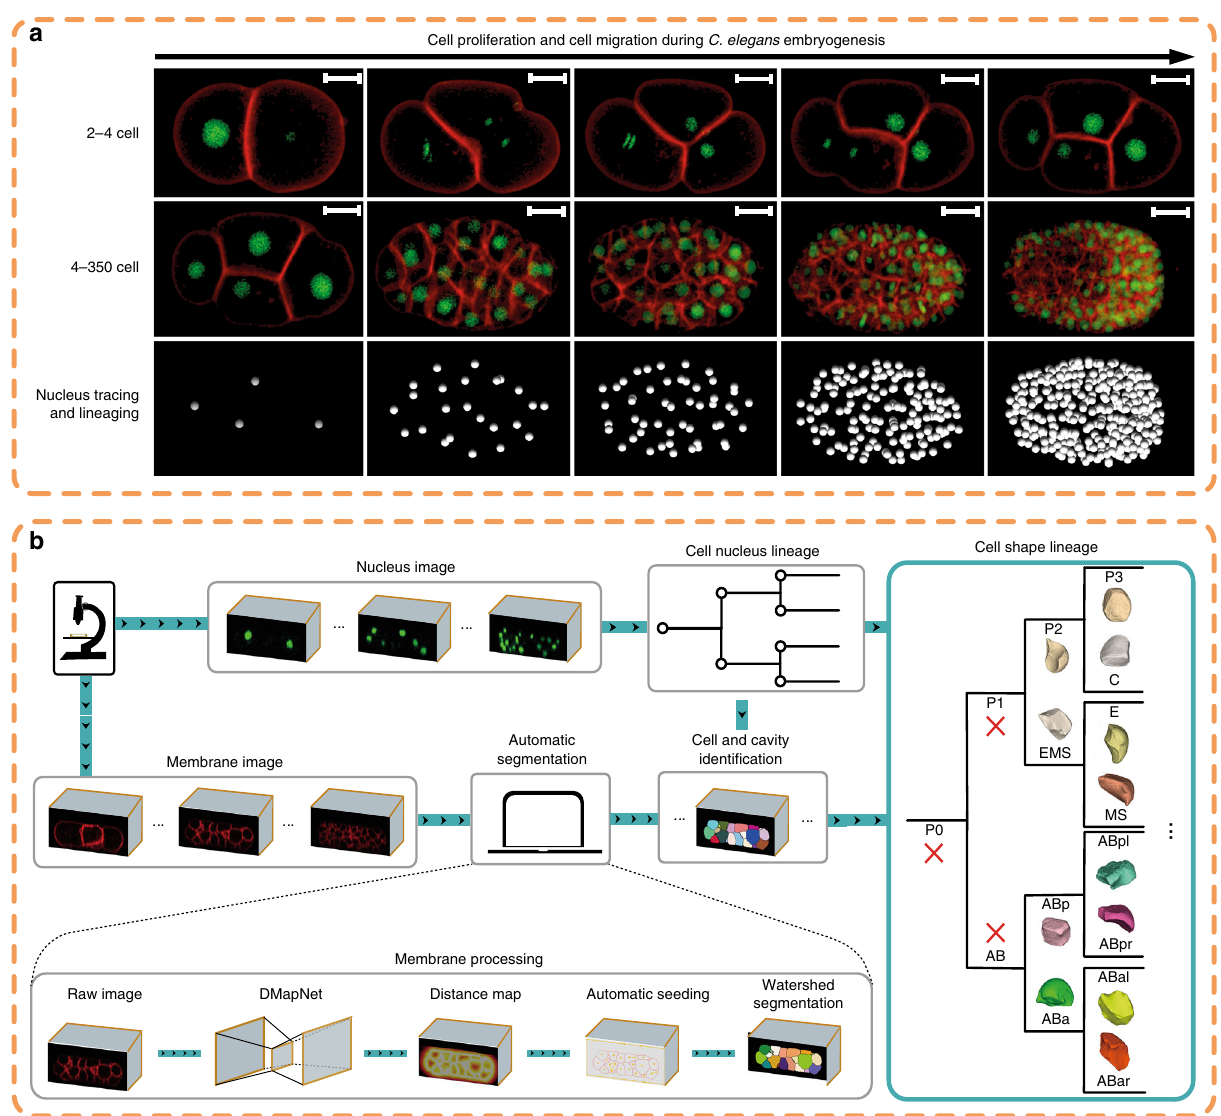
Fig. 1 CShaper pipeline. a 3D projections of image stacks of GFP-labeled nuclei (green) and mCherry-labeled membranes (red) at the selected time points between 2 – 4-cell stages (top) and 4 – 350-cell stages (middle). Nuclei positions determined by automated lineaging tools from the 4- to 350-cell stages are shown at the bottom. Scale bar, 10 μ m. b Framework of CShaper. Membrane images are transformed into discrete distance maps by a distance-aware neural network, DMapNet, after which minima clustering serves as a seeding procedure for the watershed segmentation. Based on the nucleus lineage from automated lineaging tools, membrane-wrapped compartments in the segmentations with or without a nucleus are denoted as cell or cavity, respectively. Finally, time-lapse 3D cell shapes across development with de fi ned cell identity are generated (right). Cells that do not exist during the imaging period are indicated with a red